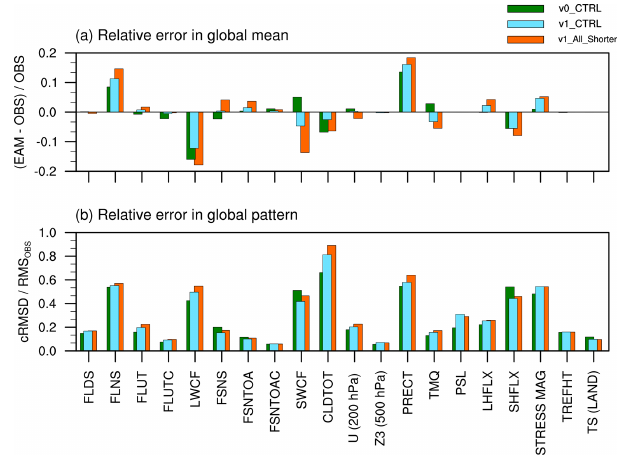
Figure 6. Comparison of 10-year mean climate simulated by v1_All_Shorter, v1_CTRL, and v0_CTRL against various reanaly- ses and satellite products. The upper panel (a) shows relative errors in the simulated global averages. The lower panel (b) shows the relative error in the simulated geographical distributions, as mea- sured by the centered root mean square difference (cRMSD) be- tween model results and the observations normalized by the root mean square of the observed global distribution (rms OBS ). The long names of the physical quantities labeled along the x axis are given in Table 2 together with the sources of observational